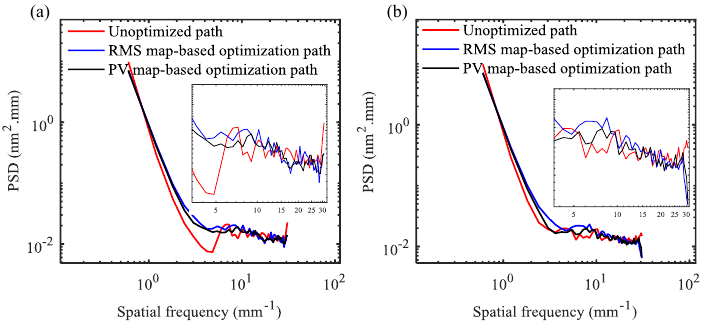
Figure 12. PSD analysis results of residual error in the ( a ) x -direction and ( b ) y -direction.